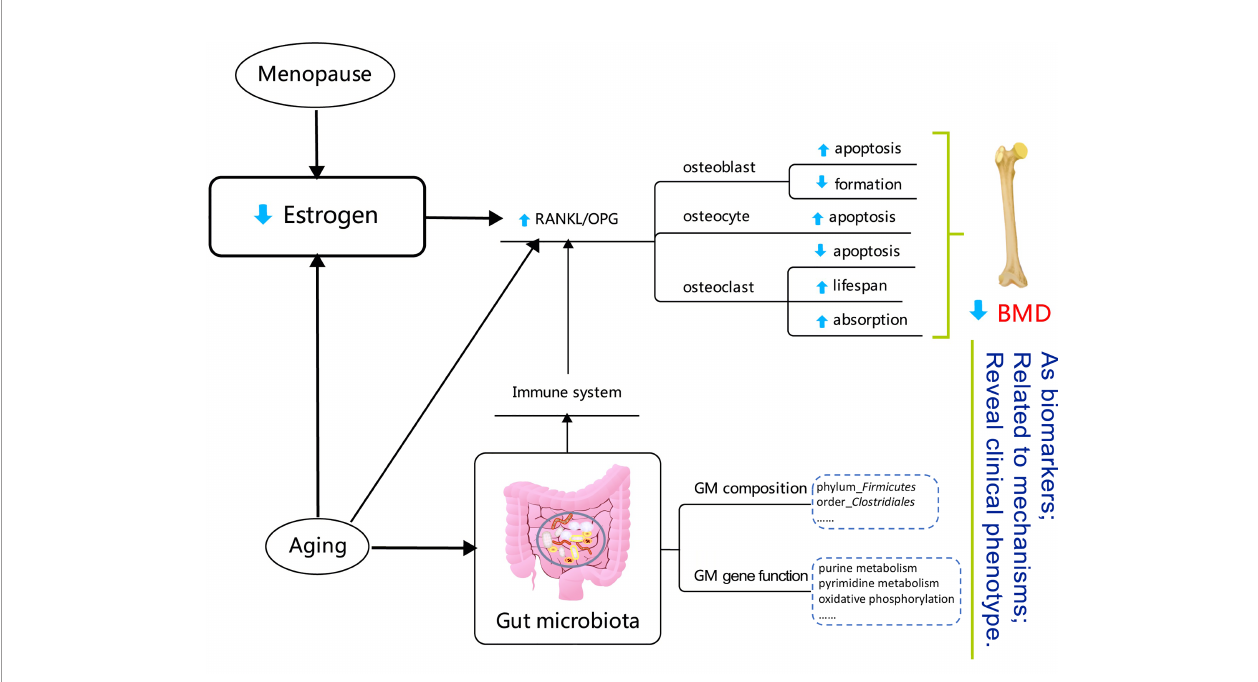
FIGURE 7 | Diagram re fl ecting the correlations between gut microbiota and a low bone mineral density in the postmenopausal female. The detail explanation of the mechanisms is summarized in the Discussion . The content in the dotted box showed the BMD-related factors in the postmenopausal female participants in this